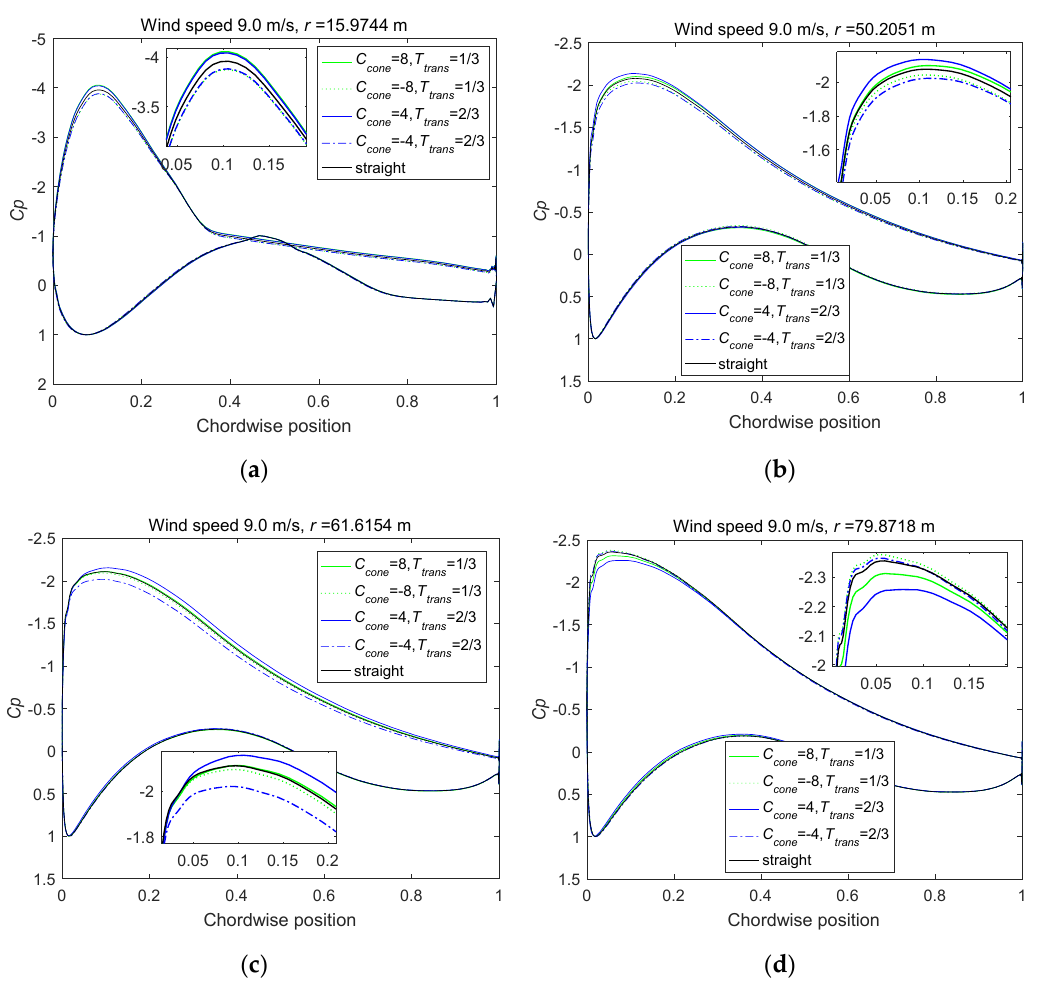
Figure 12. The pressure coefficient distributions at four radial positions (horizontal axis is normalized by the local chord length): ( a ) r=15.9744 m, ( b ) r=50.2051 m, ( c ) r=61.6154 m, ( d ) r=79.8718 m. To find the relationship with Ft , the Cp curves are not drawn along the chordwise direction. Instead, as shown in Figure 13, they are depicted along the rotor axial direction so that the integration area closed by Cp curves can reflect the Ft changes. The horizontal axis is normalized by the maximum thickness of the respected airfoil section. In Figure 13c, the special Cp distributions in the axial position range (0.5, 1), which represent the suction side, leads to an equalized Ft of the two rotors with T trans = 1 / 3. If the Cp lines in this range are observed in the clockwise direction (an axial position from 0.5 to 1, then from 1 to 0.5), the observed positions are moving from the leading edge (LE) to the maximum thickness point (MTP) and then to the trailing edge (TE). From LE to the MTP, the upwind rotor with T trans = 1 / 3 has a lower Cp than the straight rotor. From MTP to TE, the upwind one also has lower Cp . The integration areas closed by the Cp curves of the two rotors with T trans = 1 / 3 are nearly equal. In Figure 13a,b,d, the integration areas closed by Cp curves are di ff erent which leads to di ff erent Ft . Downwind coned configurations have larger integration area at r = 15.97, 50.20 m and smaller integration area at r = 79.87 m, which is consistent with the Ft lines in Figure 11b. As discussed above, the secrets of equal Ft lies in the Cp distributions on the suction side. The lines from MTP to TE in Figure 13c are different from those in Figure 13a,b,d. Back to the normally